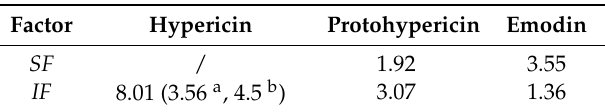
Figure 8. ( a ) The chemical structures of hypericin, protohypericin, and emodin; ( b ) Selective bindings of Fe 3 O 4 @PDA/Hyp ( black ) and Fe 3 O 4 @PDA ( red ) NSs toward to hypericin, protohypericin, and emodin, respectively. Table 5. The values of SF and IF .